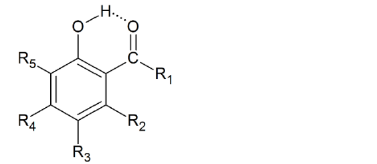
Table 1. Harmonic Oscillator Model of Aromatic stabilization (HOMA) and quasiHOMA indices and energy of the hydrogen bond (kcal/mol), calculated for unsubstituted ortho -hydroxycarbonyl compounds, substituted ortho -hydroxyaldehydes, substituted hydroxyketones and acids.